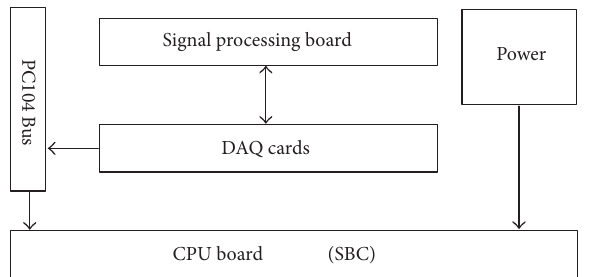
Figure 3: Hardware structure of the